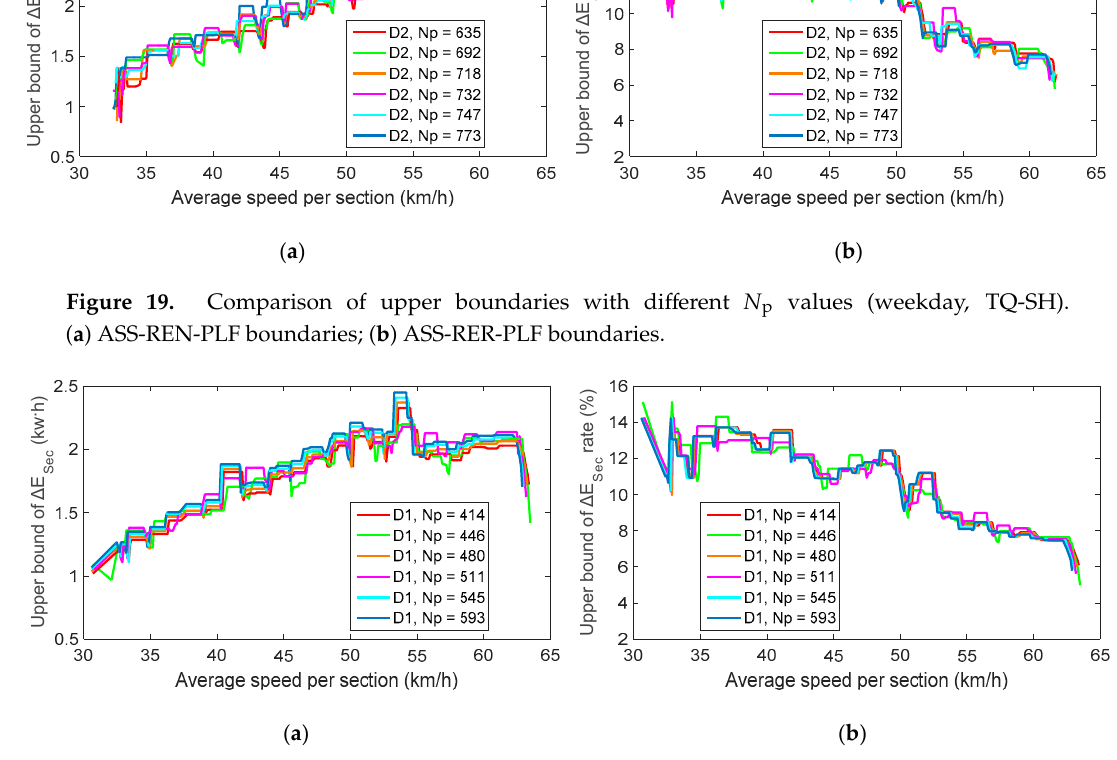
Figure 20. Comparison of upper boundaries with di ff erent N p values (weekend, SH-TQ). ( a ) ASS- REN-PLF boundaries; ( b ) ASS-RER-PLF boundaries.